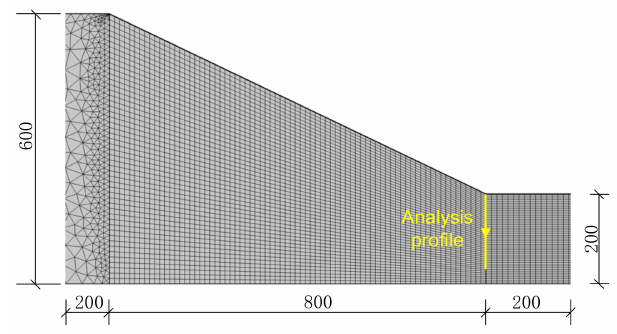
Figure 9. Slope model generalization and meshing (unit: cm).